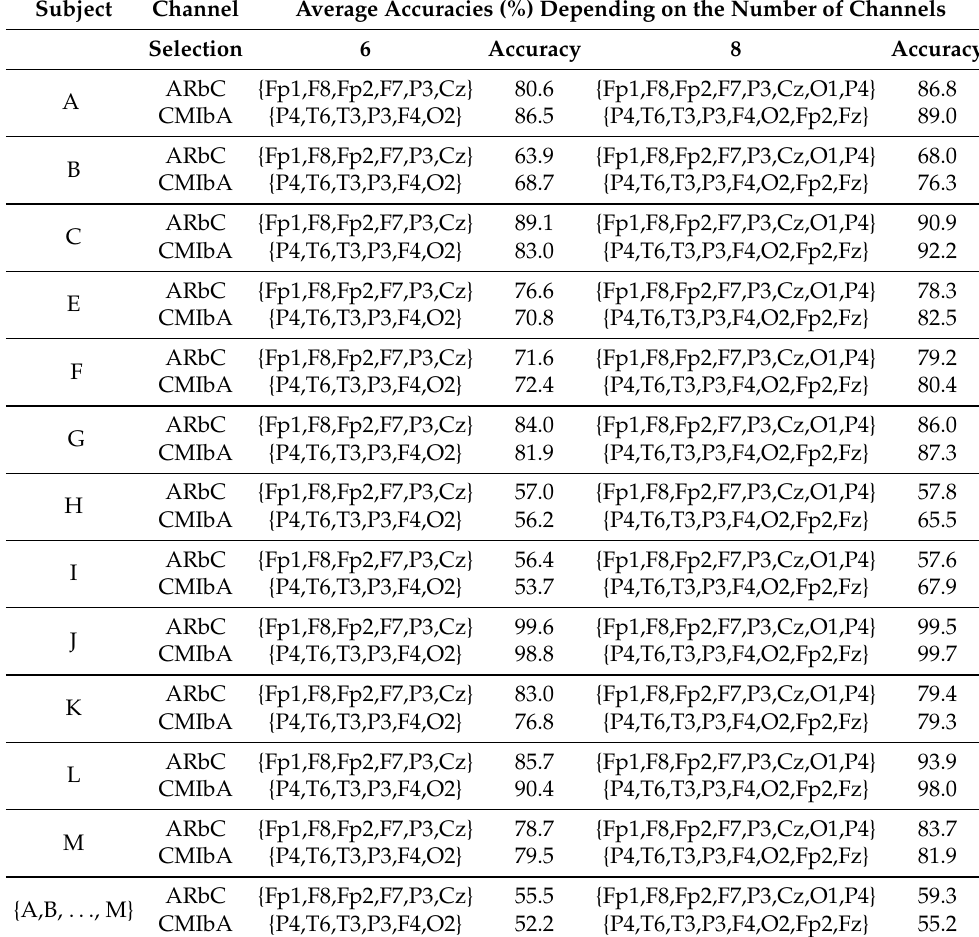
Table 8. Results achieved with the implemented channel selection